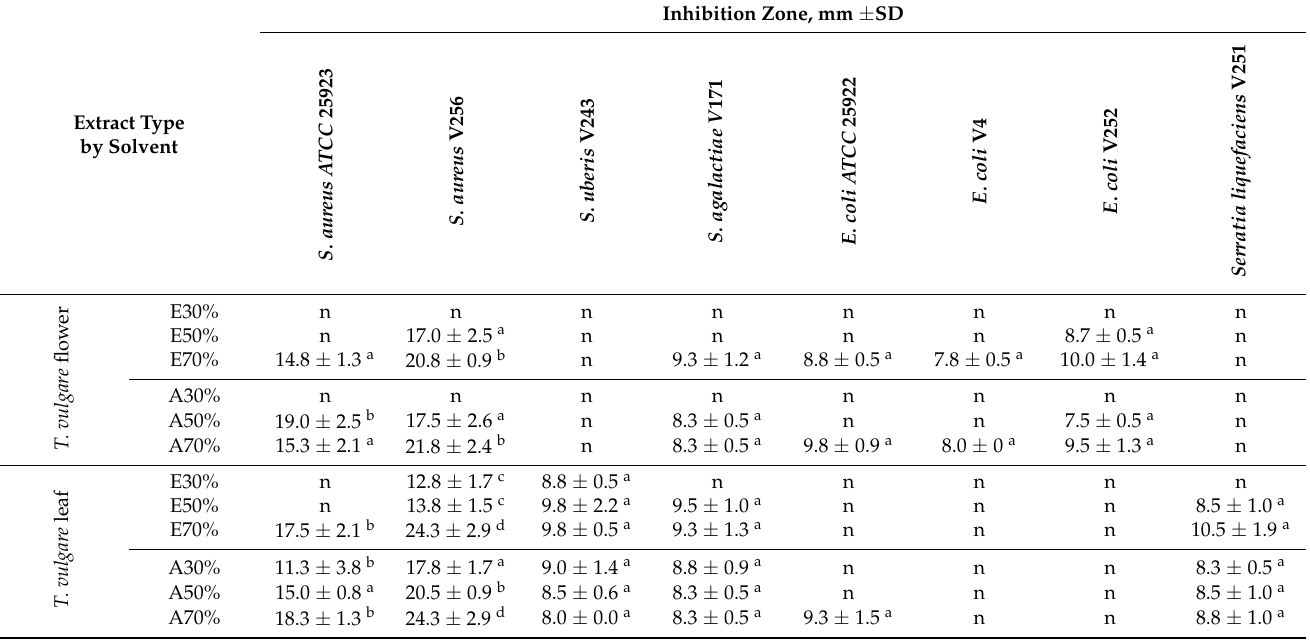
Table 2. Inhibition zones of T. vulgaris extracts for antibacterial susceptibility—agar disc diffusion test.